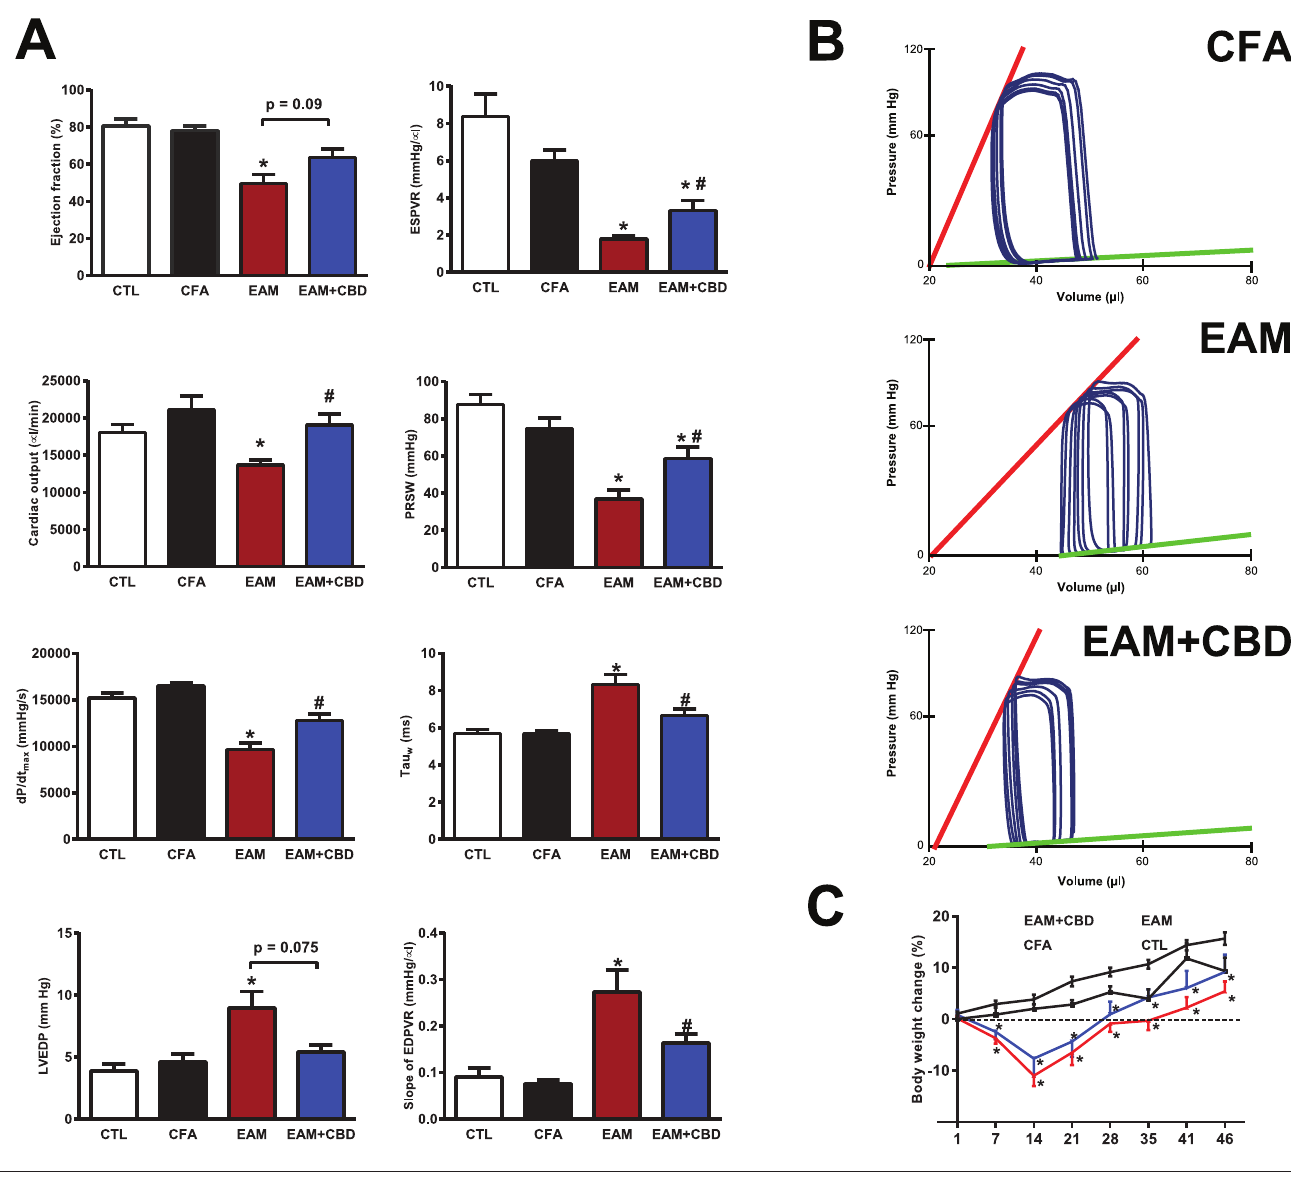
Figure 6. Effects of CBD on EAM-associated myocardial dysfunction and loss of body weight. (A) Classic indices of left ventricular systolic (ejection fraction, cardiac output, dP/dt ) and diastolic (left ventricular end-diastolic pressure [LVEDP], Tau ) and load-independent max W contractility (ESPVR), PRSW and diastolic stiffness (slope of EDPVR) parameters. (B) Representative pressure-volume loops of CFA, EAM and EAM + CBD groups. (C) Graph of body weight changes during the study course. * P < 0.05 versus CTL; # P < 0.05 versus